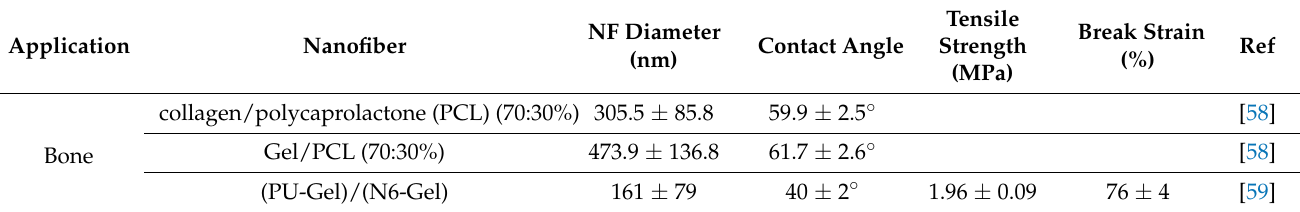
Table 1. Some of the recent electrospun nanofibers nanomaterials investigated in this review used in regeneration of tissues and